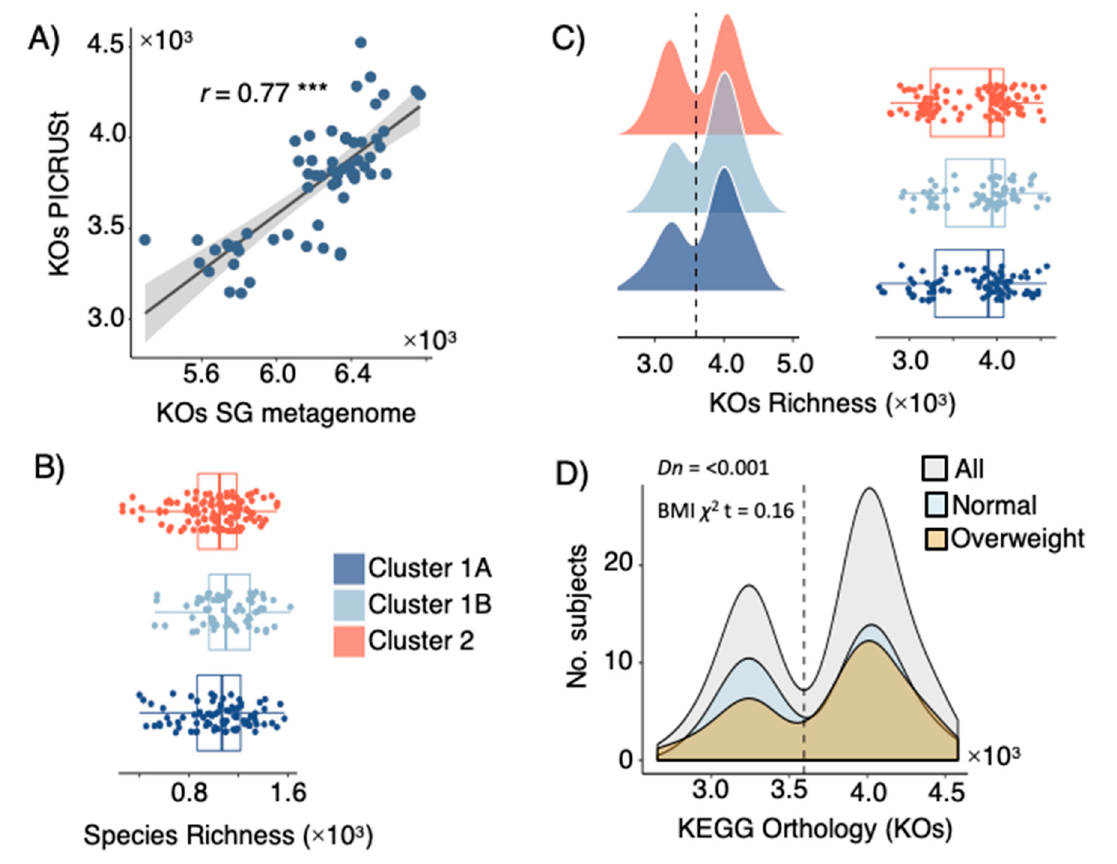
Figure 3. ( A ) Spearman’s rank correlation between fecal microbial KEGG Orthologues (KOs) from shotgun metagenome (SG) sequencing and KO predicted by PICRUSt. ( B ) Richness of microbial phylotypes (zOTUs) richness and ( C ) KO predicted by PICRUSt among subjects catalogued as being C1A, C1B and C2 based on their LPD. ( D ) KO counts (richness) among all subjects and those with BMI ≤ 25 (normal) and BMI > 25 (overweighed); the observed bimodal distribution was statistically significant by the dip-test. Stars show statistical level of significance (*** p ≤